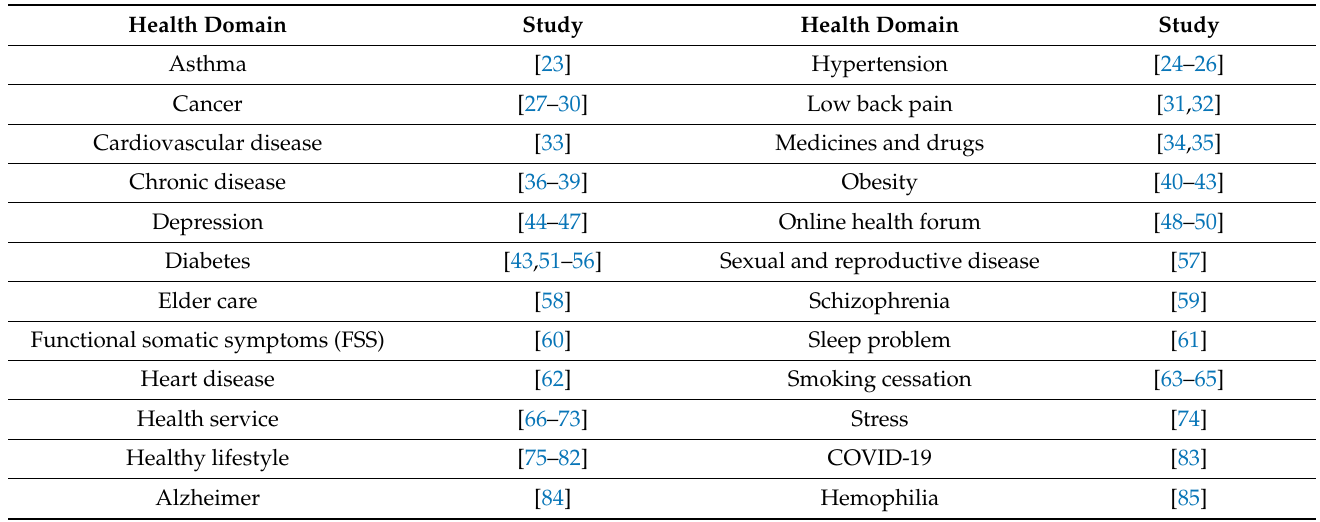
Table 2. The distribution of health domain.